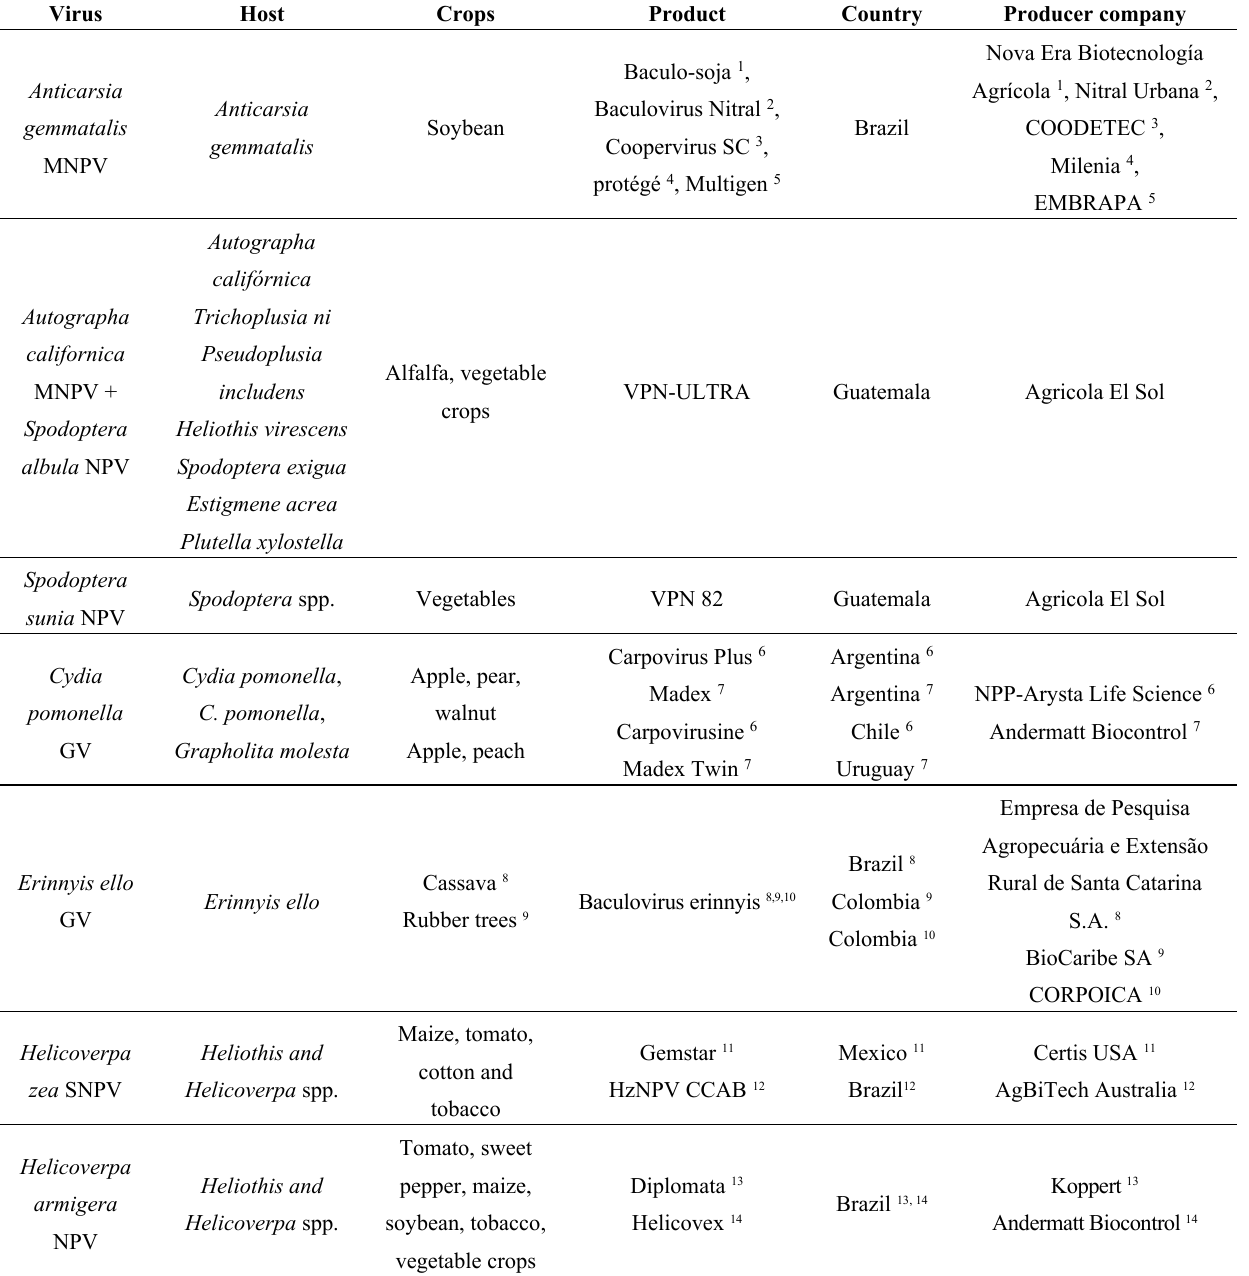
Table 1. Examples of baculovirus-based products commercialized in Latin